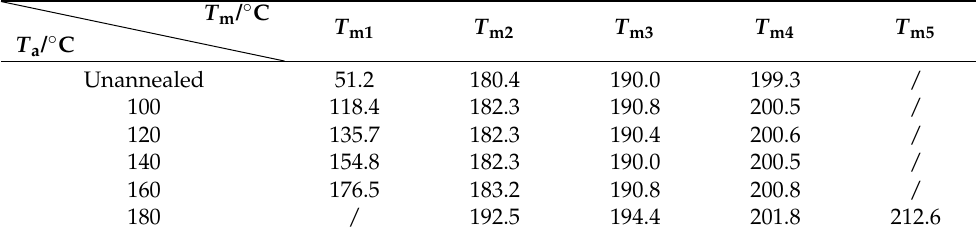
Figure 1. DSC heating curves of unannealed HD-TPU sample and samples after annealing at different temperatures. Table 1. The values of multiple melting peaks at different annealing temperatures.